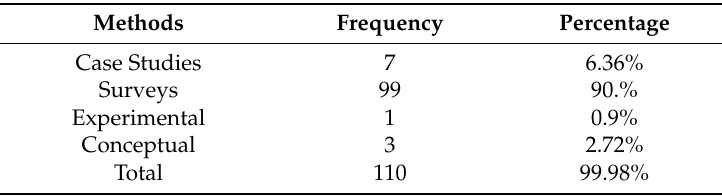
Table 3. The distribution of the research